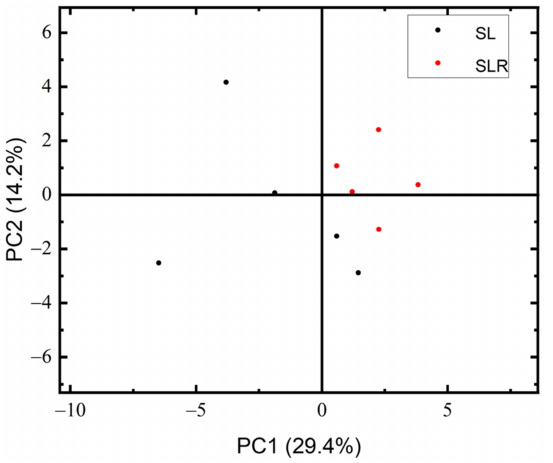
Figure 9. Principal component analysis (PCA) of the collected spectra for SL and SLR. Red dots represent SLR. Black dots represent SL.